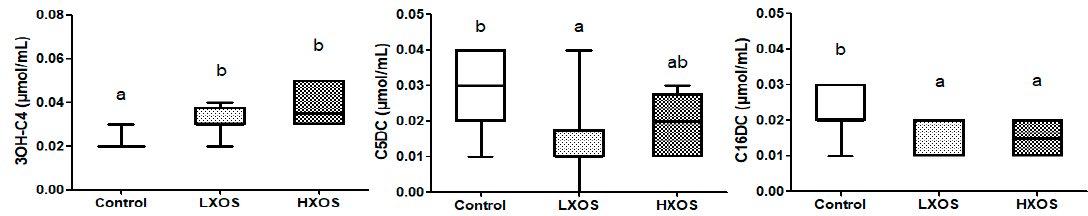
Figure 2. Effect of XOS on the blood concentration of 3OH-C4, C5DC, and C16DC. 3OH-C4: 3-hydroxybutyryl carnitine; C5DC: glutaryl carnitine; C16DC: hexadecanedioyl carnitine. Groups with different letters (a, b) are significantly different ( p < 0.05).